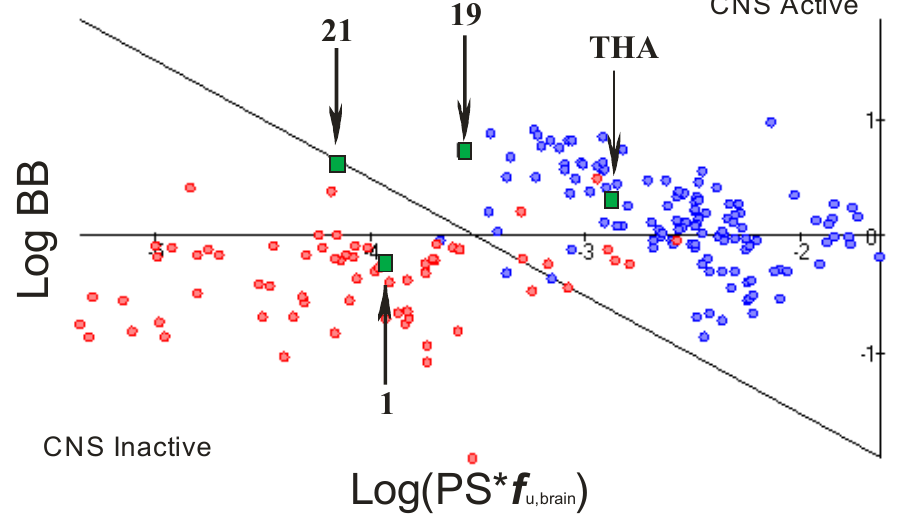
Figure 5. CNS activity plot showing known CNS-penetrating (blue points) and peripherally acting drugs (red points). The green quadrates denote some currently analyzed molecules correctly classified by our model as CNS active for compound 19 or CNS inactive for compound 1